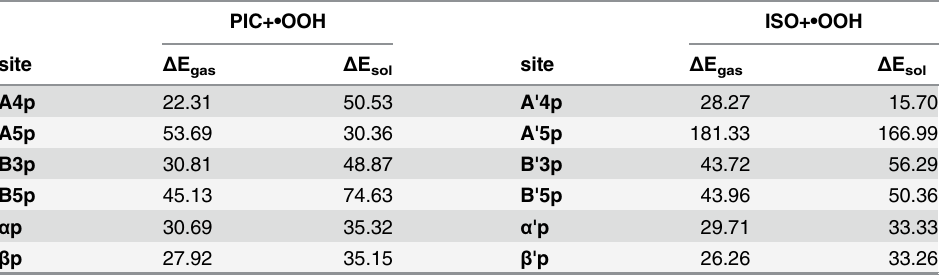
Table 6. The barrier heights of TS with zero-point energy corrections for reactions of PIC and ISO with (cid:129) OOH in the gas phase and water (in kJ/mol).